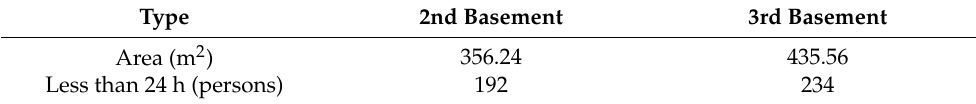
Figure 5. SIP location and areas (the area for the 2nd basement and 3rd basement). Table 3. Shelter capacity.